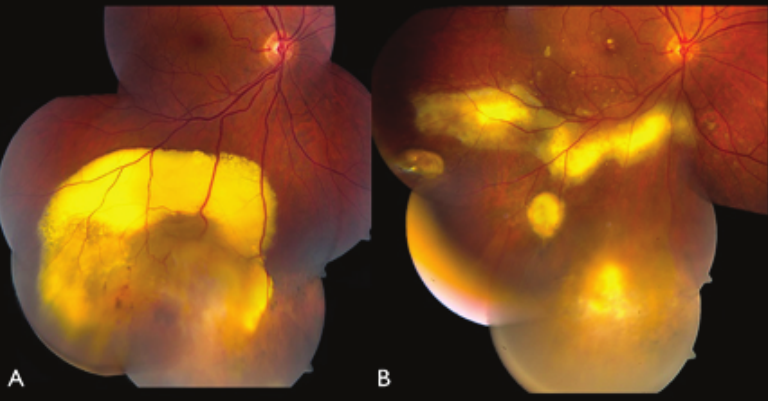
Figure 4. Fundus photograph of the right eye of a patient with a vasoproliferative tumor located inferiorly (A) before and (B) 18 months after PDT.